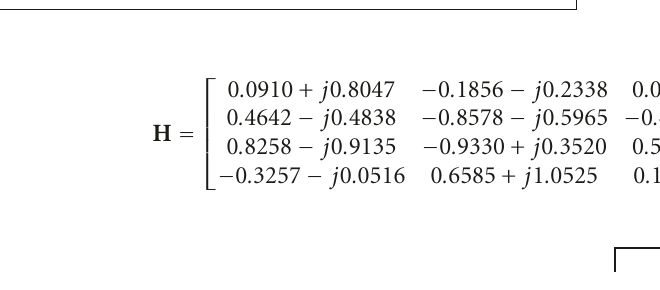
Table 1: Results of reliability metrics based on MMSE